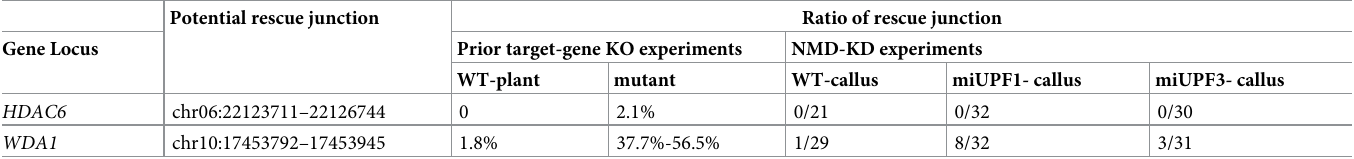
Table 1. The ratio of rescue junction detected in KO mutants and WT and NMD-related gene silencing tissue. Potential rescue